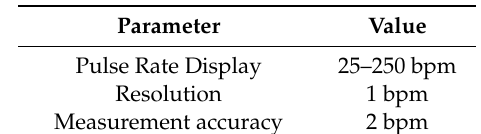
Table 5. DB12 parameters.